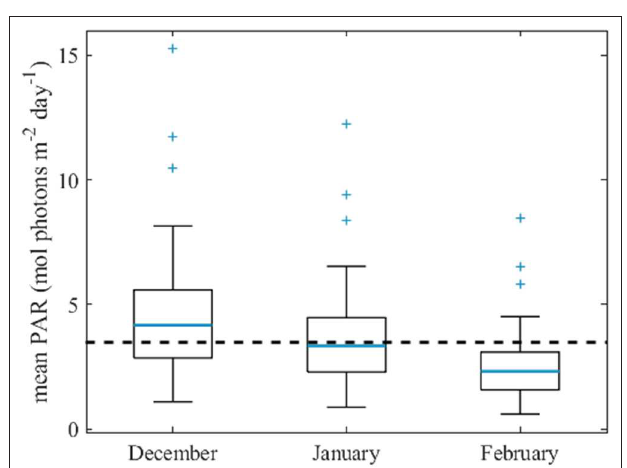
FIGURE 12 | Average daily dose of PAR within the mixed layer for the Heard and McDonald Islands and transect C stations. The average monthly surface PAR obtained from MODIS-Aqua was used for the calculations. Black dashed line represents mean daily PAR of 3.5mol photons m − 2 day − 1 and indicates light limitation conditions ( Blain et al.,